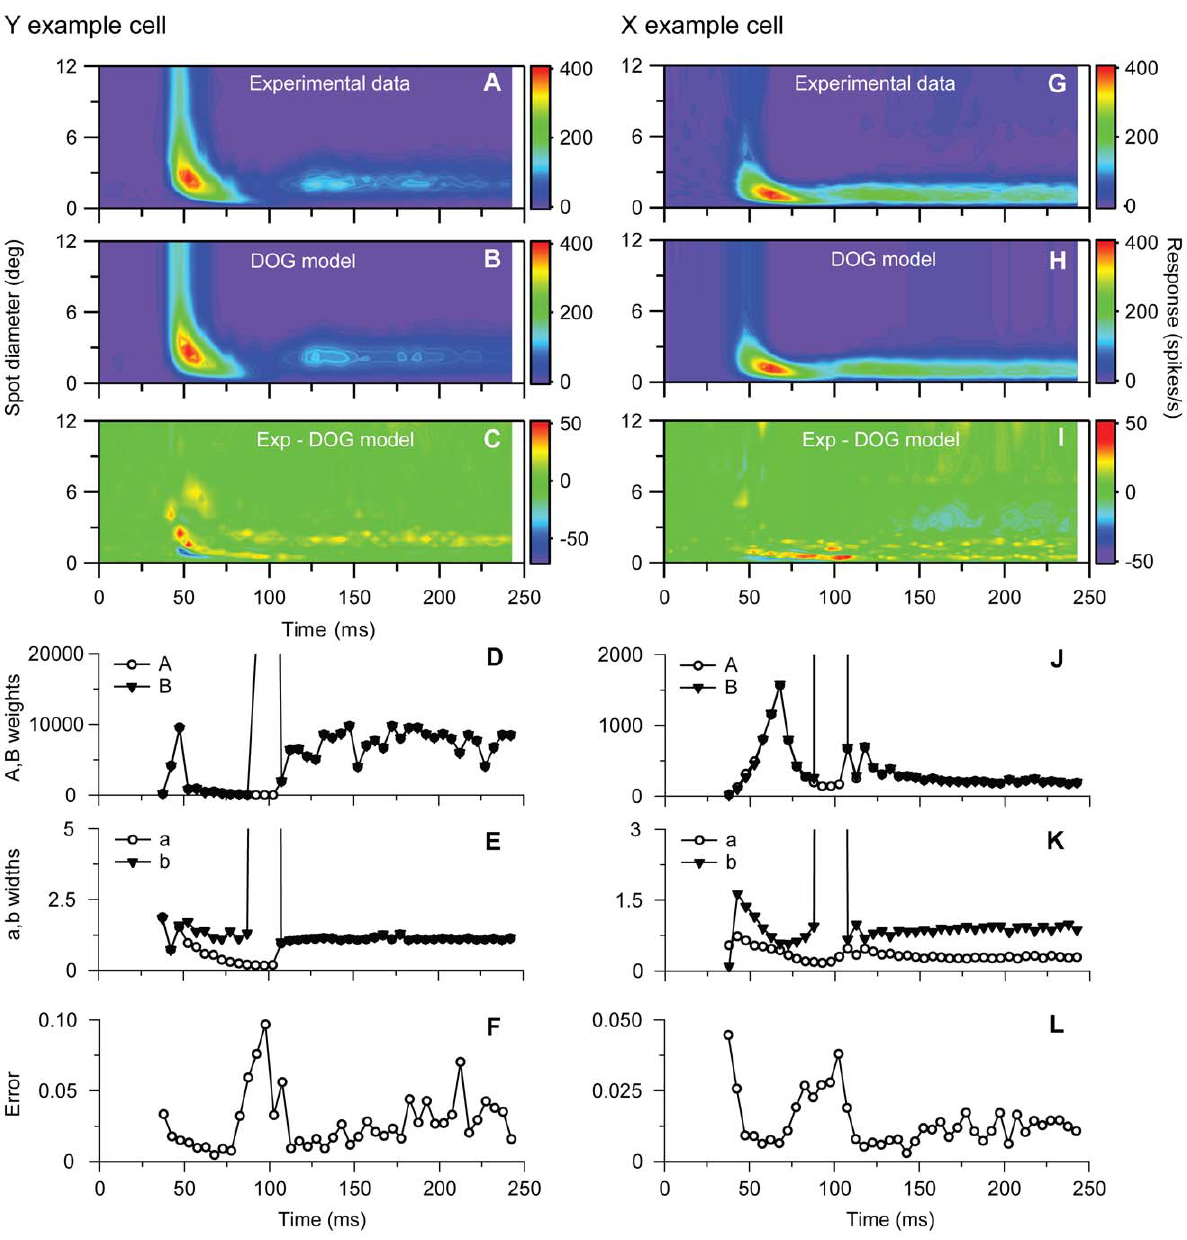
Figure 7. Fits to time-resolved DOG functions for example on-center Y and X neurons in Figs. 1 and 2. A , Experimental Y-neuron response data. B , Best fit to time-resolved DOG model in Eq. (4). C , Deviation between experimental results (A) and model results in (B). Error e (cf. Eq. 1) is 0.016. D , Fitted values of weight parameters A ( t i ) and B ( t i ) for Y neuron. E , Fitted values of width parameters a ( t i ) and b ( t i ) for Y neuron. F , Time- resolved error e t (cf. Eq. 2) for Y neuron. G–L , Same as (A)–(F) for the X-neuron response data. The deviation between experimental results (G) and model results (H) corresponds to an error e =0.012. Note that the almost vertical lines in panels (D) and (J) signal a rapid growth of the fitted value of the weight parameter B to values beyond the maximum values of the y-axes. The almost vertical lines in panels (E) and (K) correspondingly signal a rapid growth of the width parameter b .